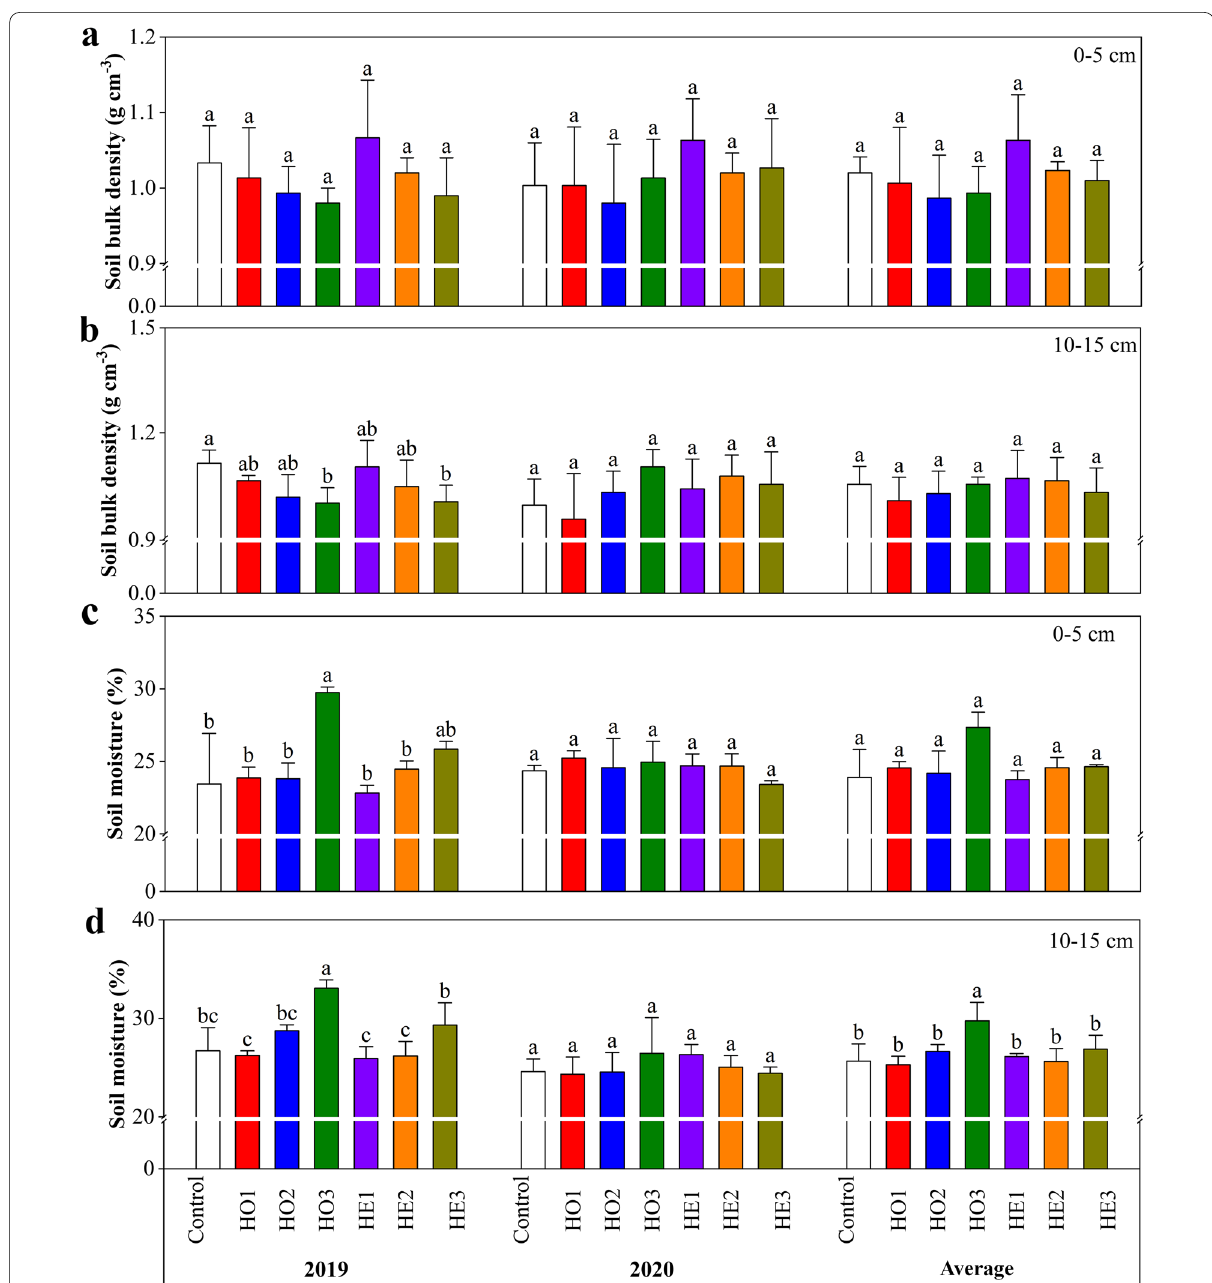
Fig. 1 Soil bulk density and soil moisture in 0–5 cm and 10–15 cm soil layers as affected by biochar application methods and amount in 2019 and 2020. a-b Soil bulk density in 0–5 cm and 10–15 cm soil layers as affect by biochar application methods and amount in 2019 and 2020. c-d Soil moisture in 0–5 cm and 10–15 cm soil layers as affect by biochar application methods and amount in 2019 and 2020. HO, homogeneous application; HE, heterogeneous application; 1, 2 and 3, biochar application was 10, 20 and 40 t ha − 1 , respectively, in both HO and HE treatments, Control, biochar application was 0. The same lowcase letter over each bar in the same cropping stage represents no significant difference ( P > 0.05) between